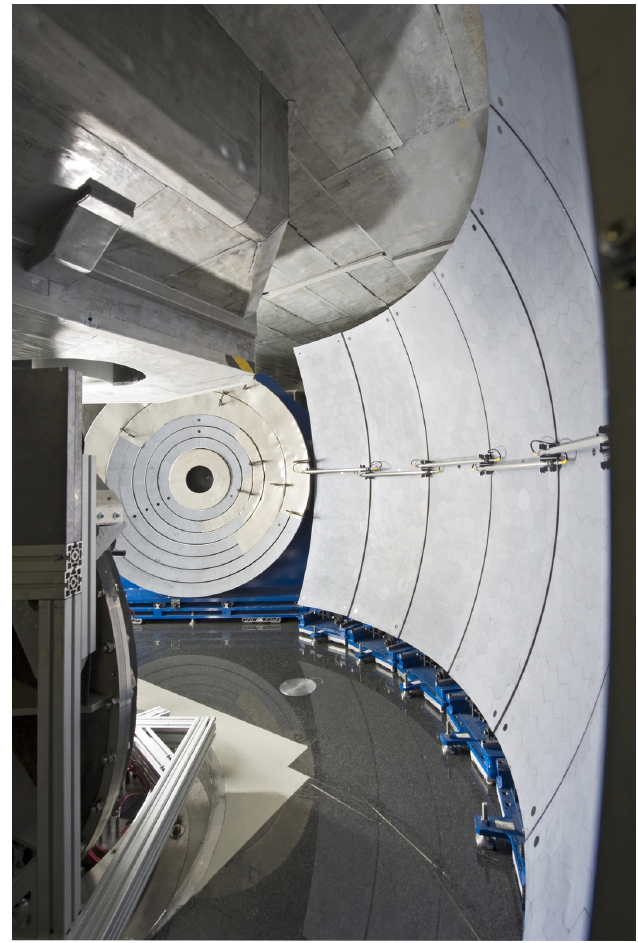
Figure 1: View inside SPHERES: the large array of Si(111) analyzer crystals covers a solid angle of about 2.5, which is 20 % of 4 π (Copyright by A. Heddergott, TUM). As a multi-detector instrument with relaxed angular resolution, SPHERES is particularly suited for studying tagged-particle motion by incoherent scattering. Typical applications include for example dynamical processes in polymers and biological systems (Gallat et al., 2012). The high resolution and sensitivity of the spectrometer allows to investigate the dynamics of water in confined geometry and deep in the supercooled state (Doster et al., 2010). The high count rates allow inelastic temperature scans (Häußler et al., 2011) and real-time kinetic experiments (Léon & Wuttke, 2011). Further applications are hyperfine splitting in magnetic materials (Chatterji et al., 2008) and rotational tunneling (Bator et al.,